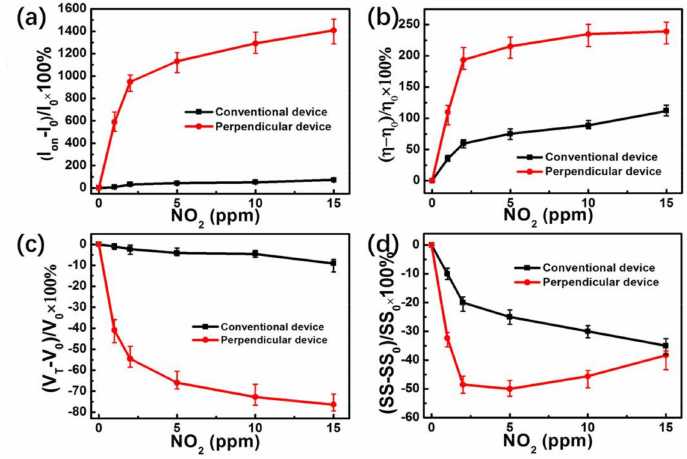
Figure 3. Variation of I on ( a ), µ ( b ), V T ( c ), and SS ( d ) of OTFTs at different NO 2